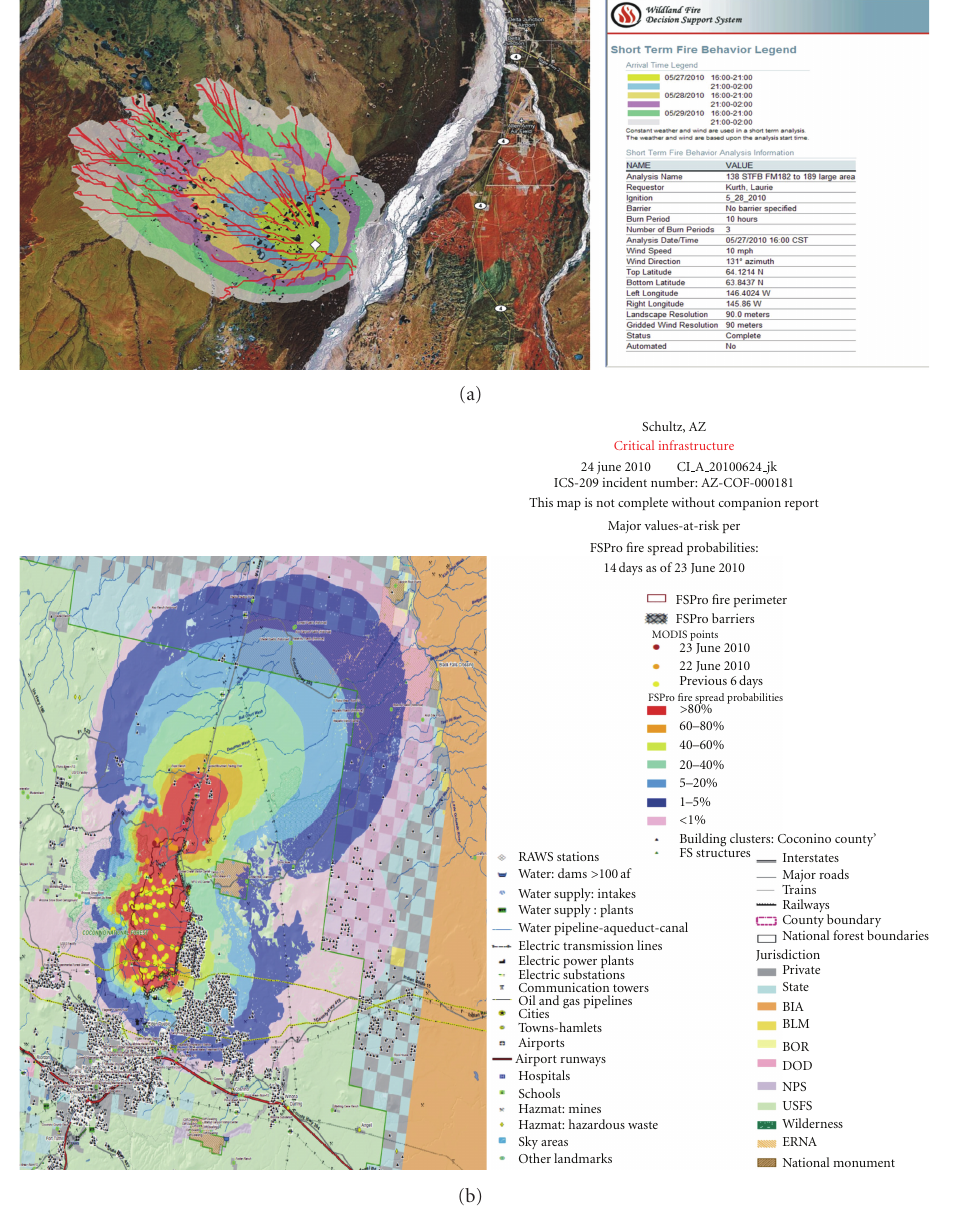
Figure 3: (a) Short-term fire behavior results for the Mississippi Impact Area fire in Alaska (AK-MID-000138) from May 2010. The simulation was for three 10-hour burn periods under constant wind and weather conditions. Shaded areas display fire arrival times in 5- hour intervals. Red vectors represent the major fire spread pathways based on the minimum travel time (MTT) algorithm [14]. (b) Critical infrastructure intersected with FSPro probabilities [16] for the Schultz fire in Arizona (AZ-COF-000181) from June 2010 illustrates the graphical output associated with a rapid assessment of values at risk (RAVAR). This map displays the probability of fire spread impacting critical infrastructure, such as structures, gas pipelines, and power transmission lines over a 14-day period based on simulating 2000 fires.